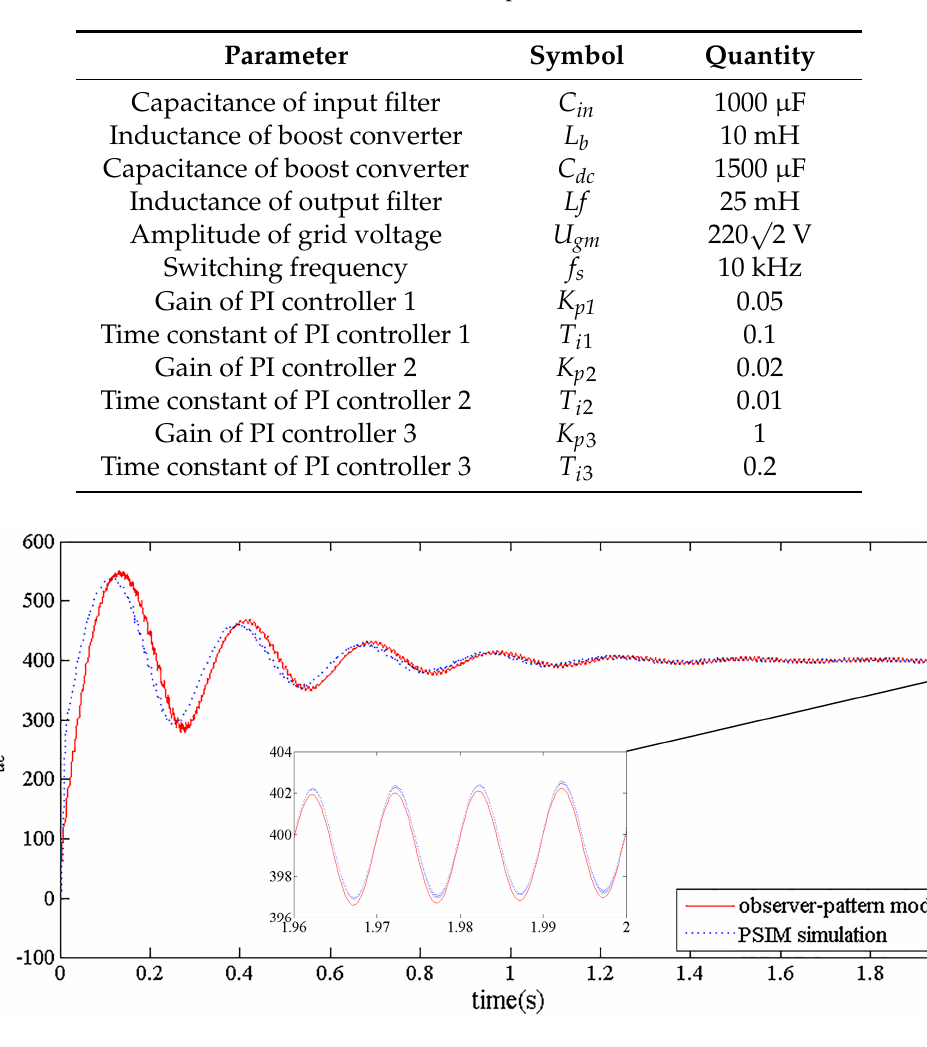
Figure 2. DC bus voltage waveform.